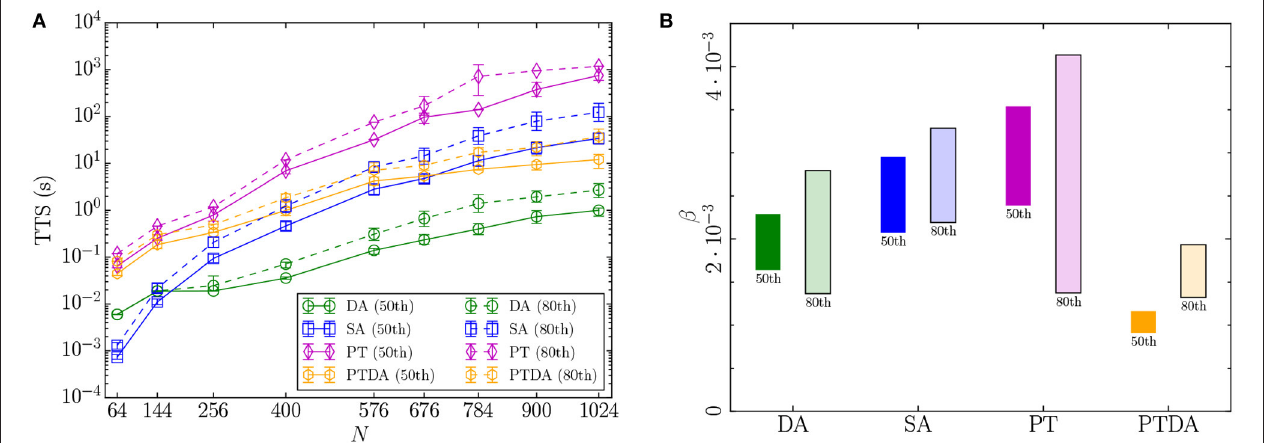
FIGURE 7 | (A) Mean, 5th, and 95th percentiles of the TTS distributions (TTS 50 and TTS 80 ) for fully connected spin-glass problems with bimodal disorder. For some problem sizes, the percentiles are smaller than the symbols. (B) The 90% confidence interval of the estimated scaling exponent β based on the mean of the TTS 50 and TTS 80 for the SK-bimodal problem class. The label below each rectangle represents the TTS percentile on which the confidence interval is based. For each algorithm, the five largest problem sizes have been used to estimate the scaling exponent by fitting a linear model to log 10 TTS. The R 2 of the fitted model is greater than or slightly lower than 90 % for each